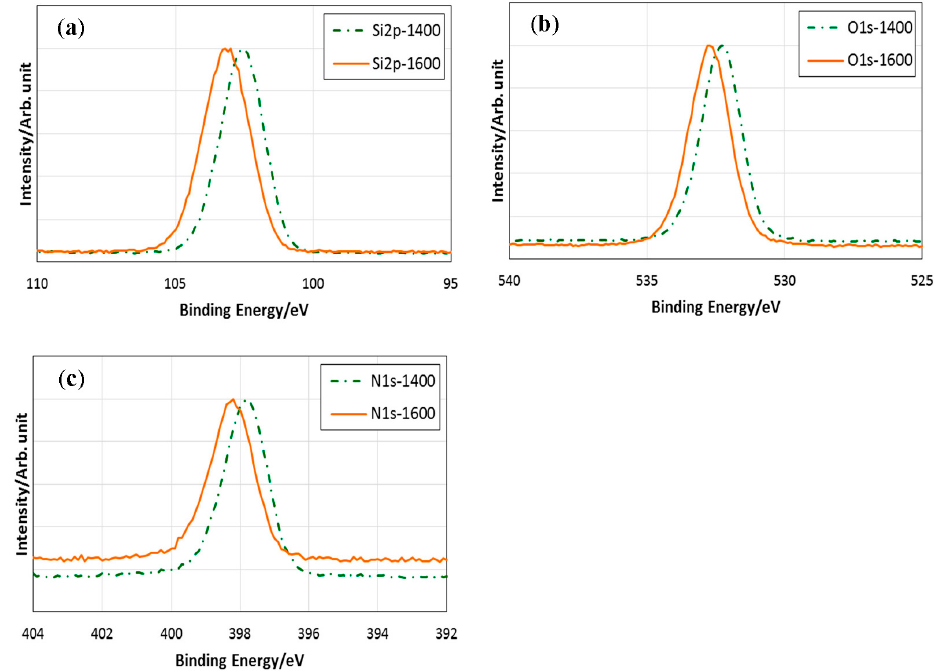
Figure 8. X-ray photoelectron spectroscopy (XPS) spectra for 1400 °C- and 1600 °C-heat treated samples; ( a ) Si2 p ; ( b ) O1 s ; and ( c ) N1 s regions.